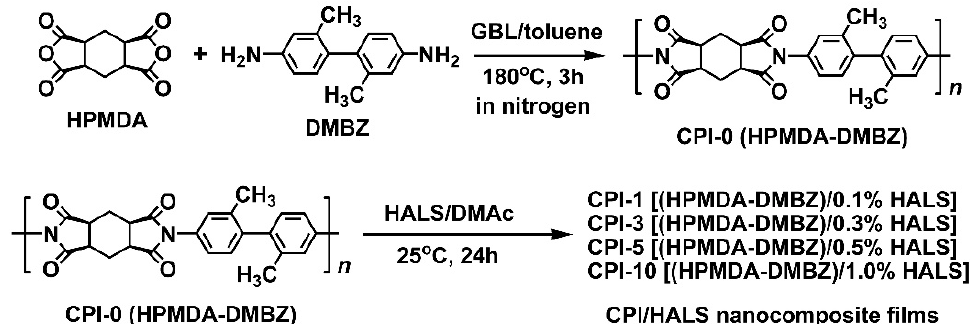
Figure 5. Preparation of CPI-0 and the CPI/HALS nanocomposite films.